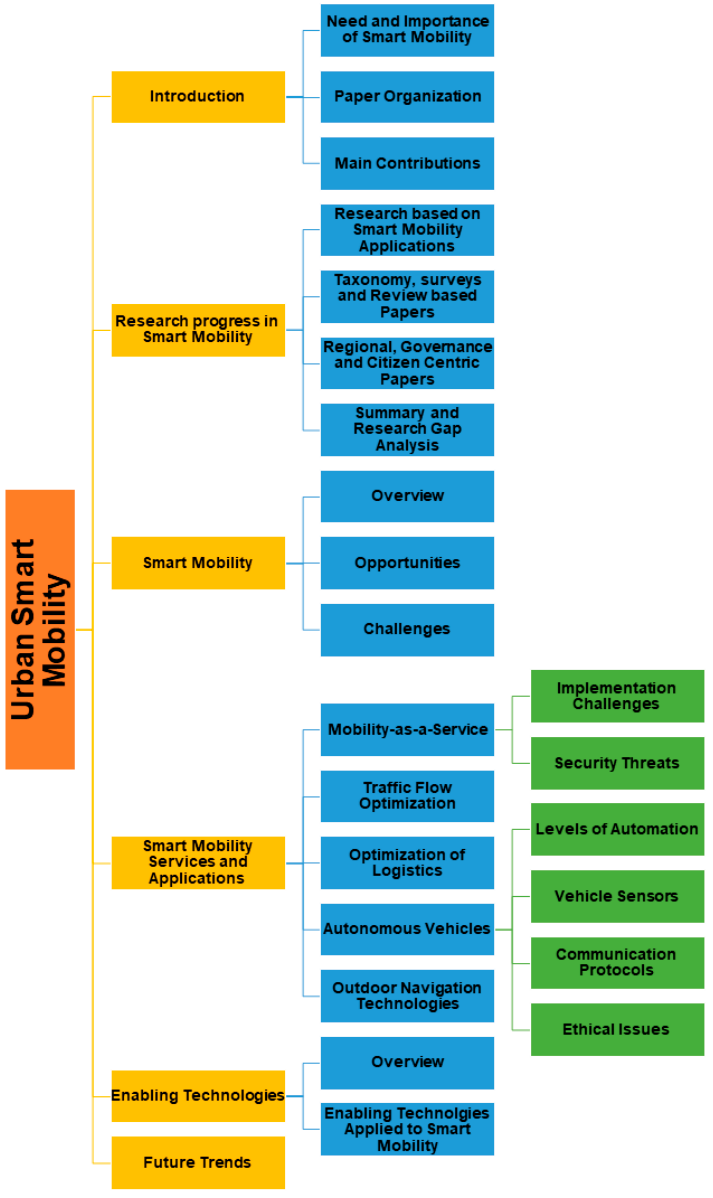
Figure 2. Overview on the paper organization.